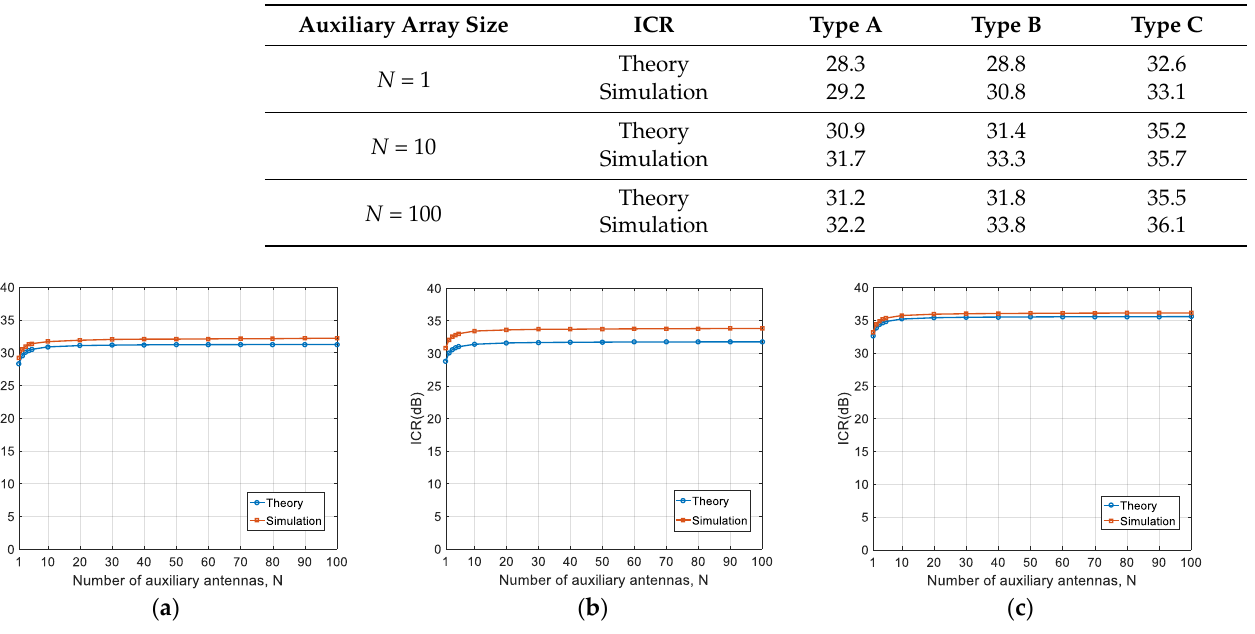
Table 2. The values of ICR.